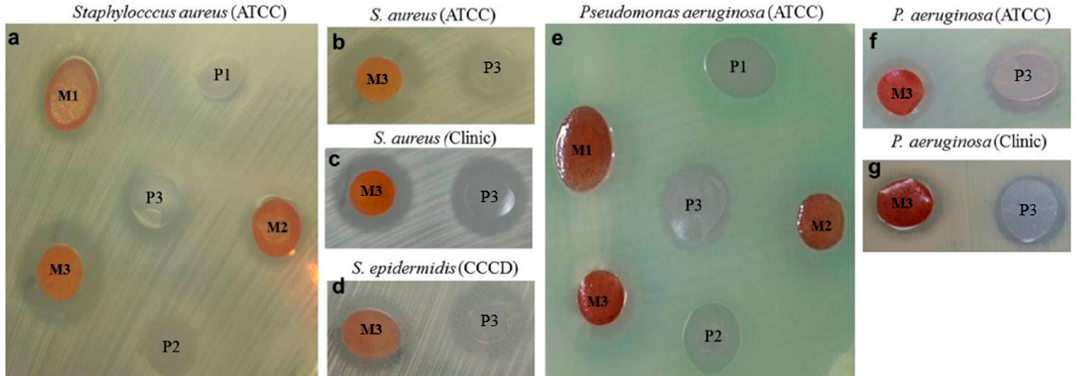
Figure 5. Antimicrobial activity of the membranes against Gram-positive and Gram-negative bacteria after 24 h by the disk-diffusion technique, using M1, M2 and M3 (loaded with RPE) and P1, P2 and P3 as their respective control membranes. ( a ) Zones of inhibition produced by the polymer hydrogel membranes loaded with RPE against Staphylococcus aureus ATCC 25923. The M3 against ( b ) Staphylococcus aureus ATCC 25923; ( c ) clinical isolated of S. aureus; ( d ) S. epidermidis CCCD 5010 and ( e ) Zone of inhibition produced by the polymer hydrogel membranes loaded with RPE against Pseudomonas aeruginosa ATCC 27853. The M3 against ( f ) P. aeruginosa ATCC 27853 and ( g ) clinical isolated of P. aeruginosa.